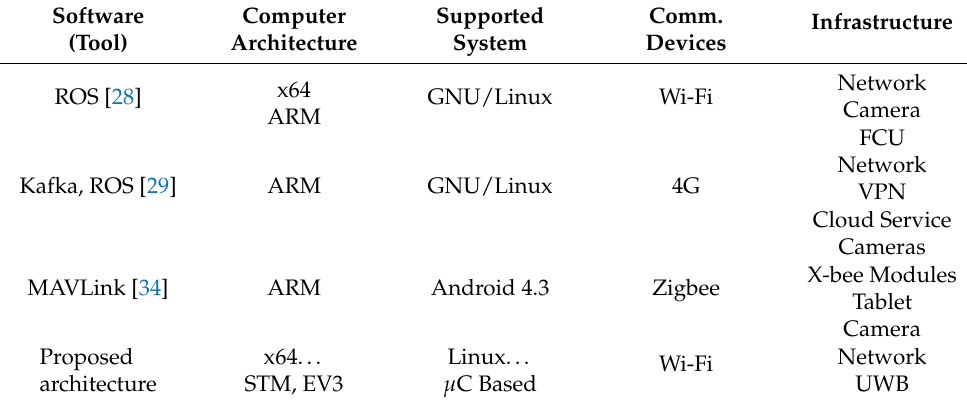
Table 1. Comparison between similar applications and